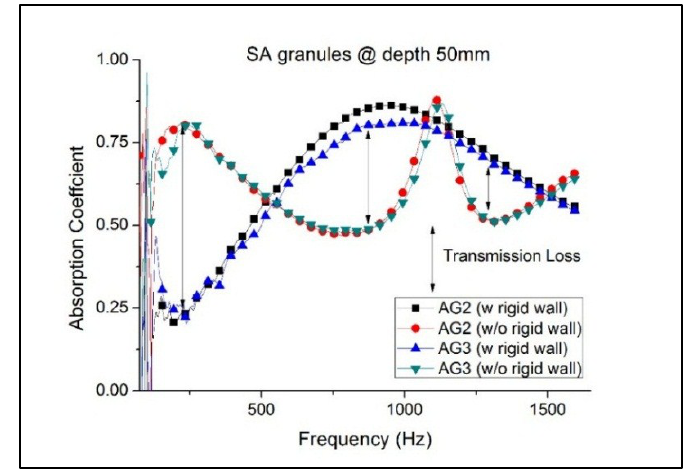
Figure 2. Comparison of AG2 and AG3 granules’ absorption coefficients at 50 mm thickness (with and without rigid